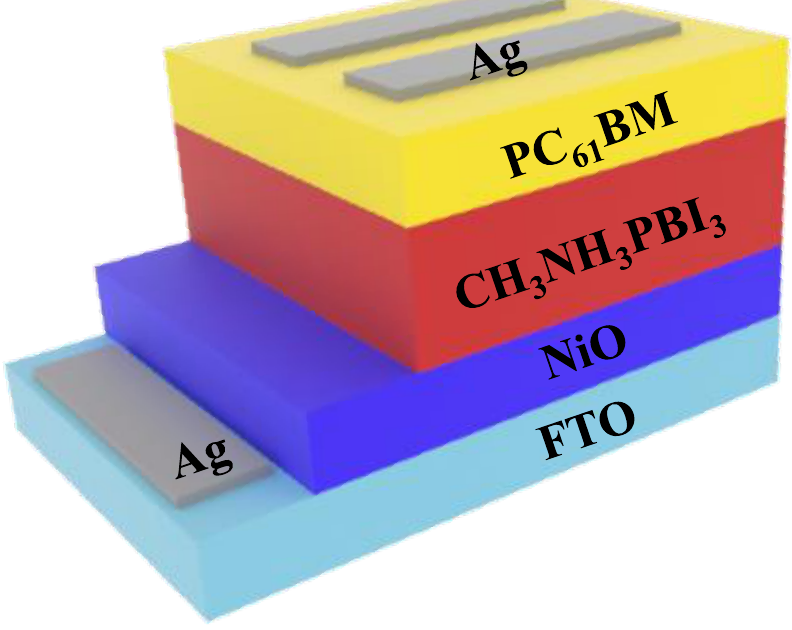
Figure 1. A schematic diagram of the perovskite solar cell (PSC).